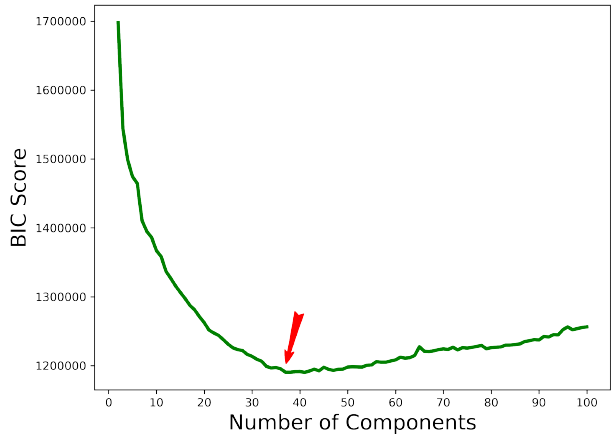
Figure 3. The BIC is plotted as a function of the number of components k . Clustering is carried out via GMM on structures generated via HEA on a target protein (known native structure in the PDB entry with identifier (id) 2h5nd). The red arrow points to the value for k identified at the lowest BIC